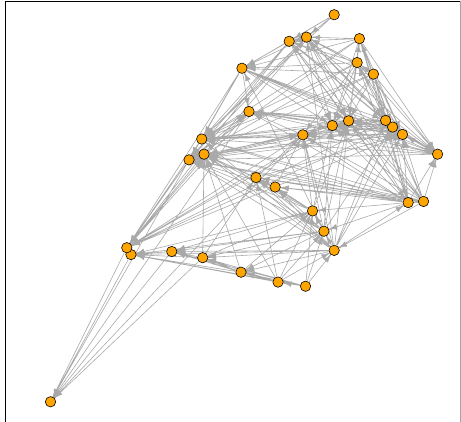
Figure 13. A directed network for the flood events showing syn- chronization and flow direction (arrows). The dots show the stream- flow gauges in their geographical location (see Fig.